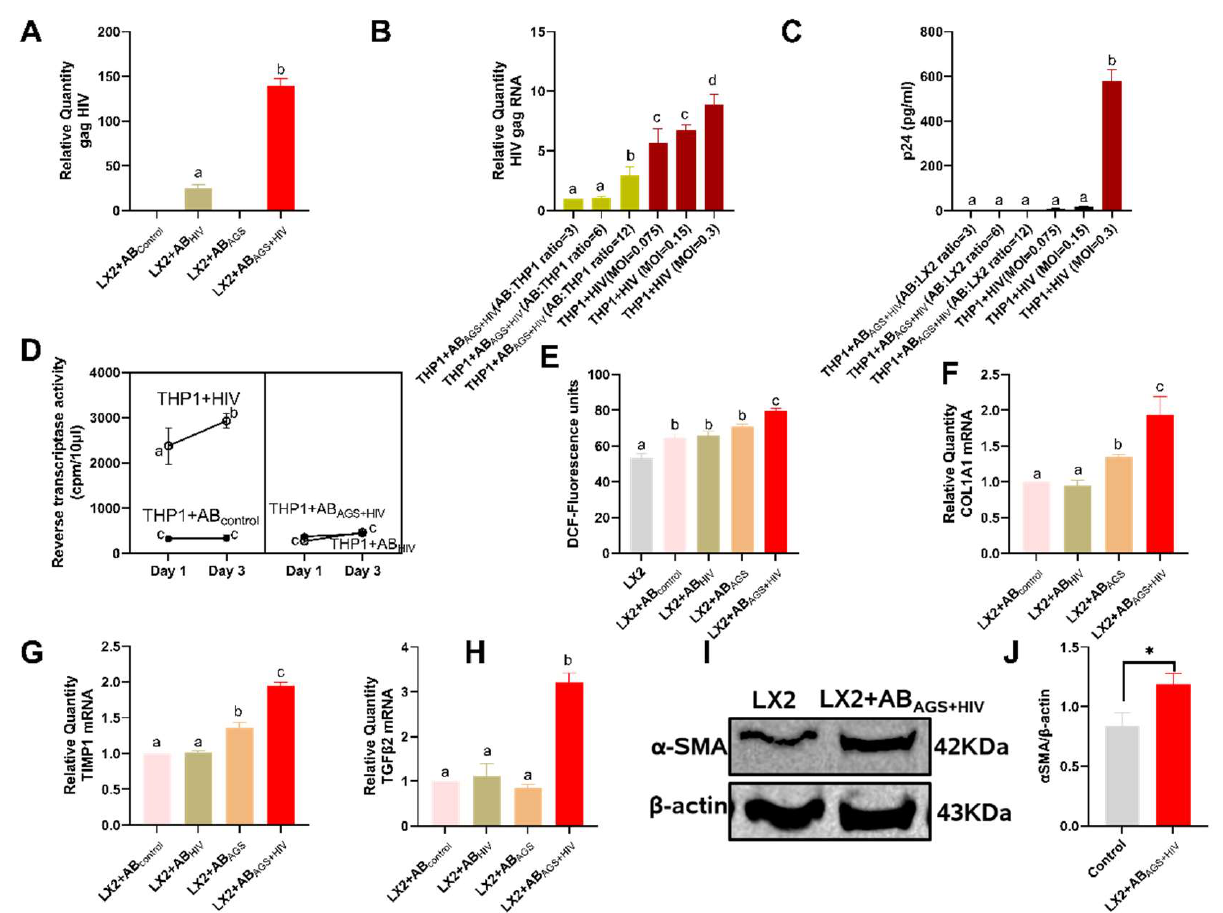
Figure 5. Engulfment of AB AGS+HIV enhances HIV RNA and ROS in LX2 cells leading to their profibrotic activation: ( A ) RT-PCR analysis of HIV gag RNA expression in LX2 cells after engulfment of AB AGS+HIV . ( B ) RT-PCR analysis of HIV gag RNA expression in THP-1 cells after 48 h exposure to RLW AB AGS+HIV . ( C ) Quantification of HIV p24 levels in the culture media from THP1 exposed to RLW AB AGS+HIV for 48 h by ELISA. ( D ) RT activity in THP-1 cells exposed to RLW AB AGS+HIV . Open dots represent THP1 cells exposed to HIV1 ADA ; closed dots represent THP1 cells exposed to Abs. ( E ) ROS generation after 48 h exposure of LX2 cells to RLW AB AGS+HIV (2′,7′-dichlorodihydrofluorescein diacetate assay). RT-PCR analysis of ( F ) COL1A1 mRNA, ( G ) TIMP1 mRNA, and ( H ) TGFβ2 mRNA of LX2 cells exposed to RLW AB AGS+HIV for 2 h. ( I , J ) α-Smooth muscle actin (SMA) of LX2 cells exposed to RLW AB AGS+HIV for 48 h was measured by immunoblot analysis and the quantification of immunoreactive protein bands. Equal amounts of protein (20 µg) were loaded in each lane. β-actin was used as an internal control. Data are from 3 independent experiments presented as mean ± SEM. Bars marked with the same letter are not significantly different; bars with different letters are sig- nificantly different from each other. Bars with * are significantly different from each other ( p ≤ 0.05).